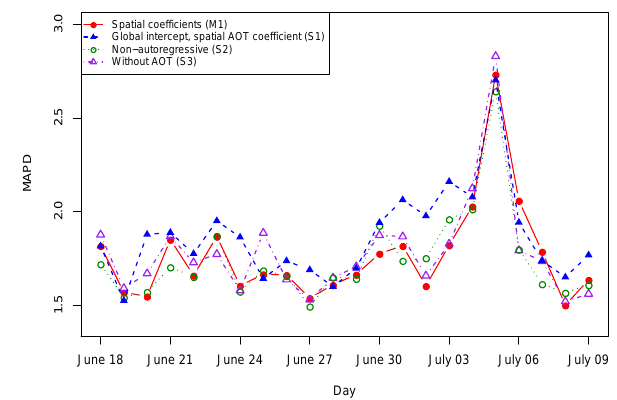
Figure 7. Daily MAPD for the out-of-sample locations under the competing models.